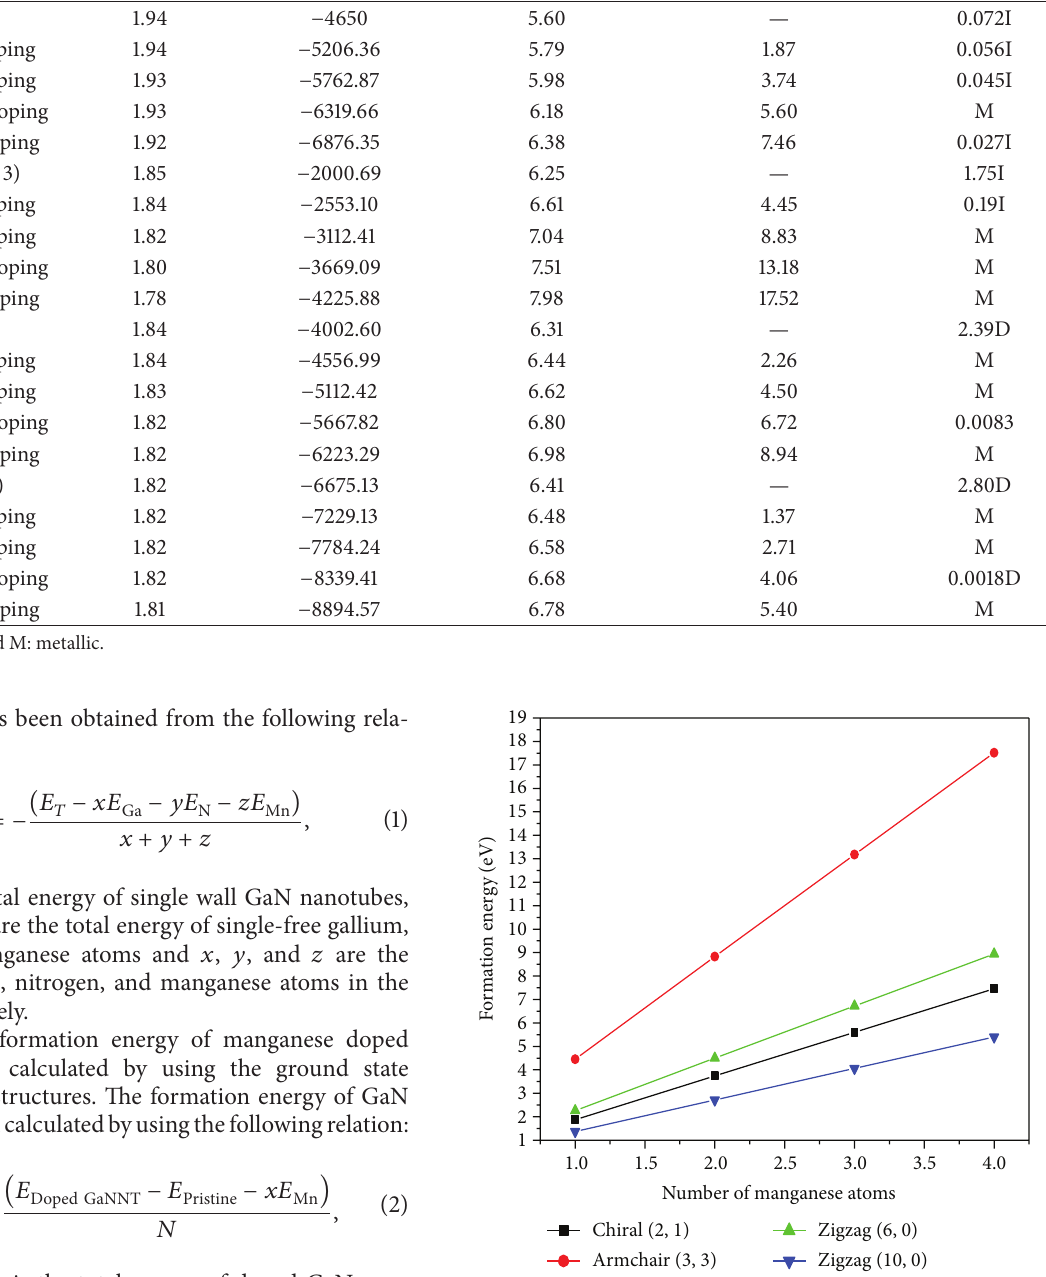
Figure 3: Formation energy as a function of Mn atoms, where black square,redcircle,greenuppertriangle,andbluebelowfacedtriangle correspond to chiral (2, 1), armchair (3, 3), (6, 0), and (10, 0), and zigzag GaN nanotubes,